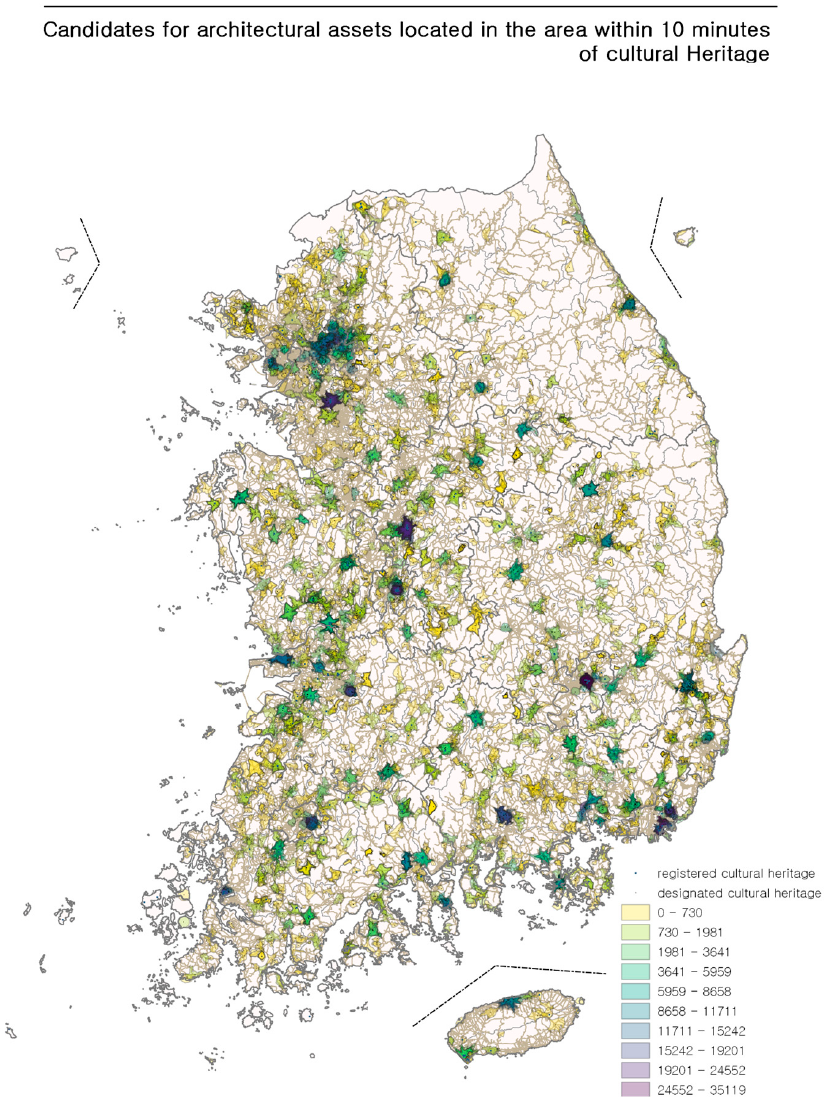
Figure 5. Candidate areas for AAVE zones.